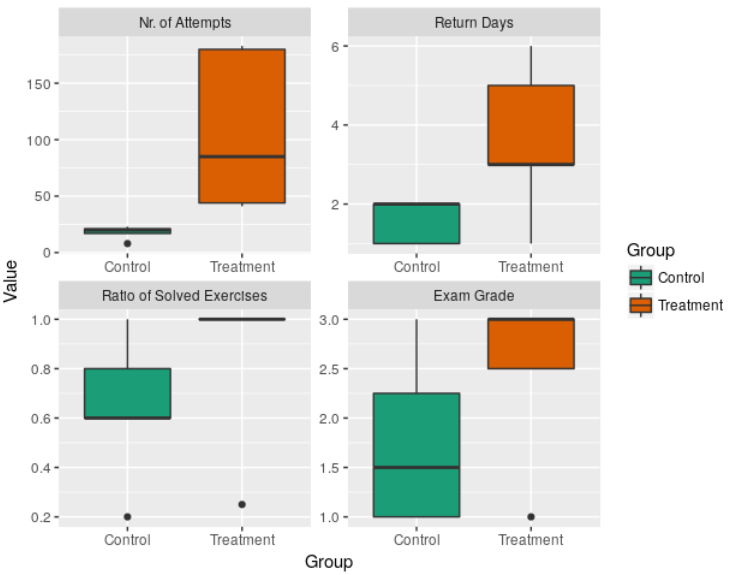
Figure 5. Quantitative comparison of metrics per group: number of attempts, return days, ratio of solved exercises, and exam